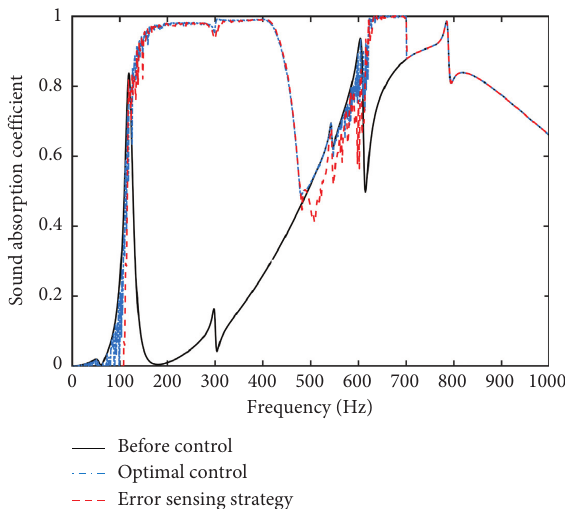
Figure 12: Active control results for the case of panel dimension being 0.2 m × 0.2m.